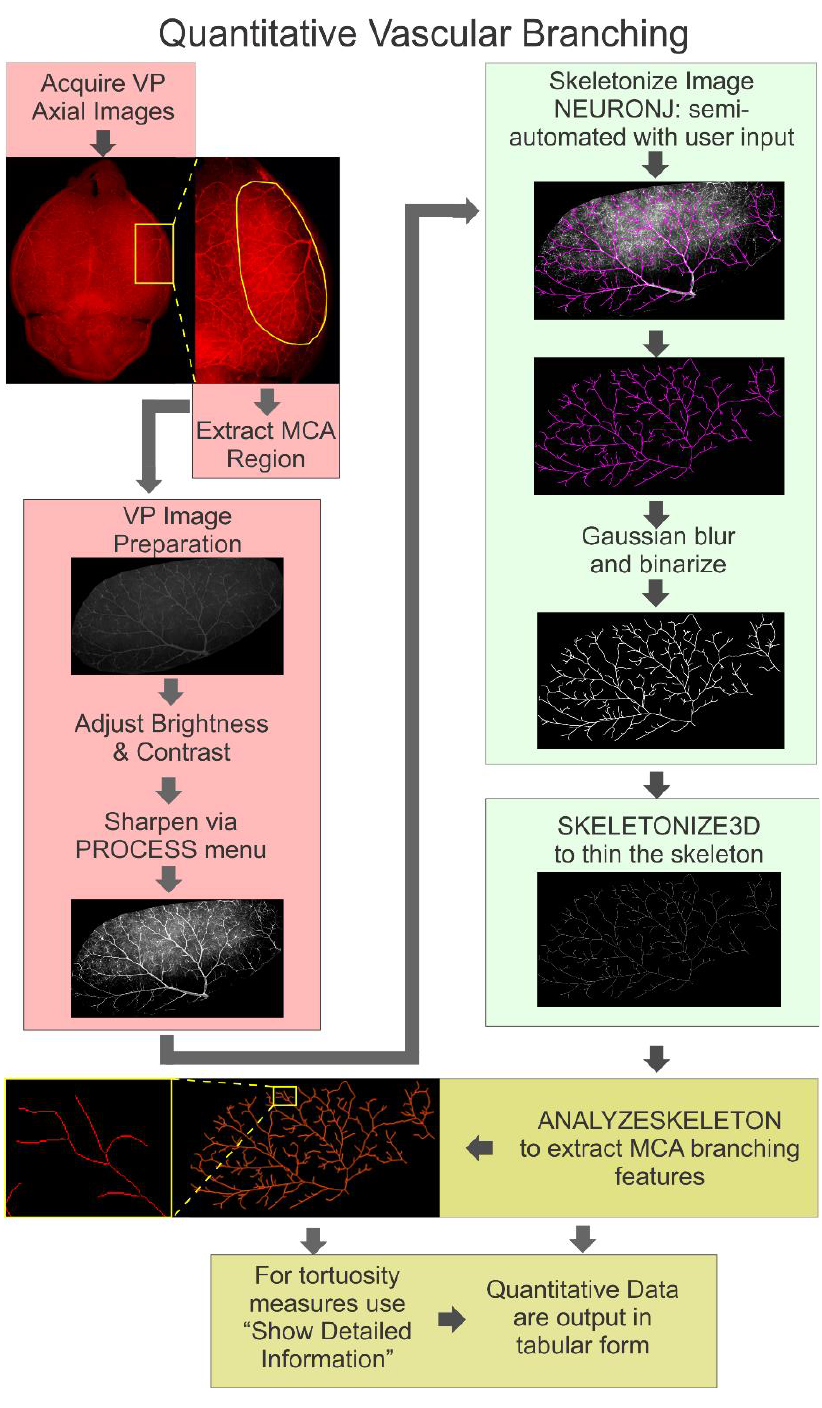
Figure 1. Workflow of middle cerebral artery (MCA) skeletonization. The skeletonization workflow consisted of five main stages: image acquisition, image preparation, NeuronJ tracing, skeleton thinning, and extraction of branching features. Fluorescent microscopy acquired images from vessel-